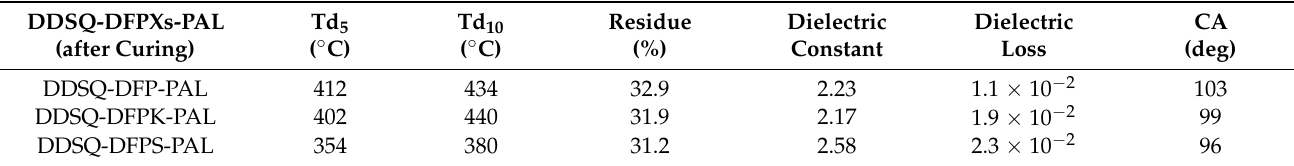
Figure 6. ( a ) DSC curves of the DDSQ-DFP-PAL; ( b ) DSC curves of the DDSQ-DFPK-PAL; ( c ) DSC curves of the DDSQ- DFPS-PAL. Table 2. The properties of DDSQ-DFPXs-PAL after